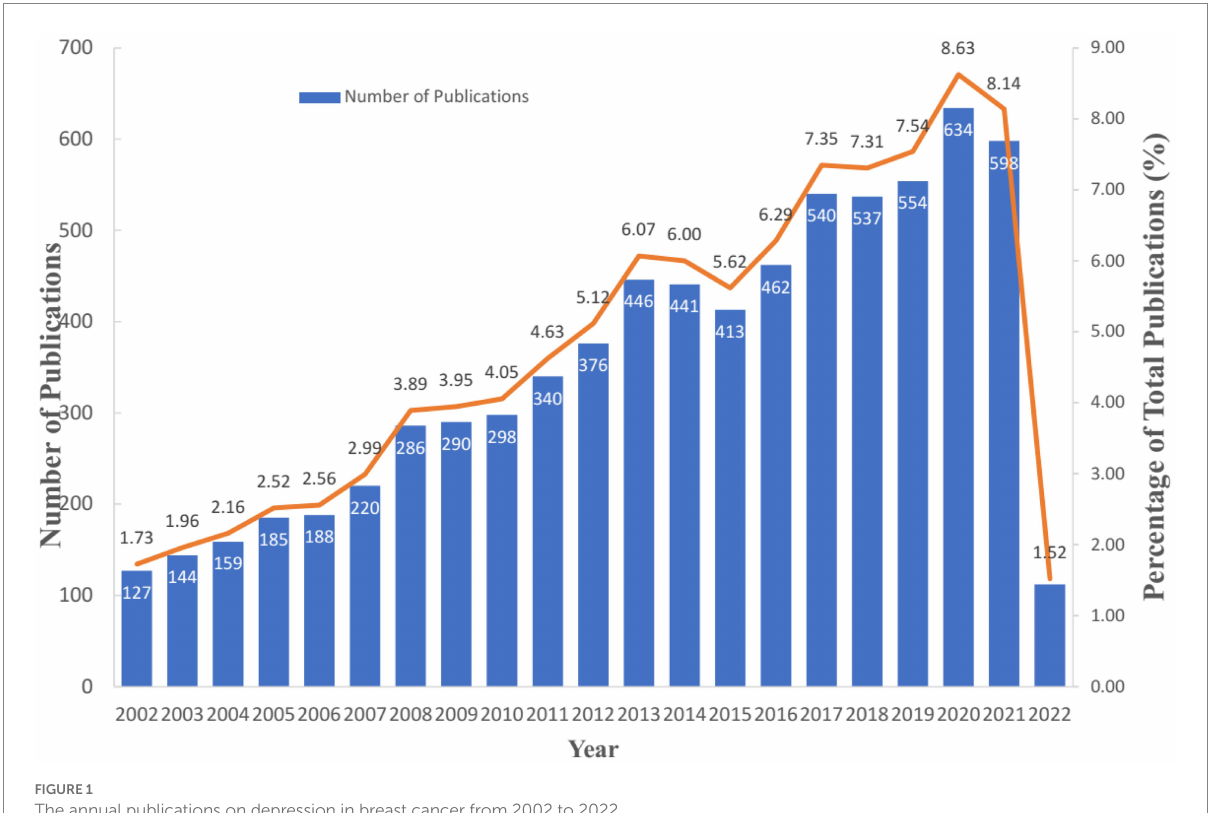
FIGURE 1 The annual publications on depression in breast cancer from 2002 to 2022.